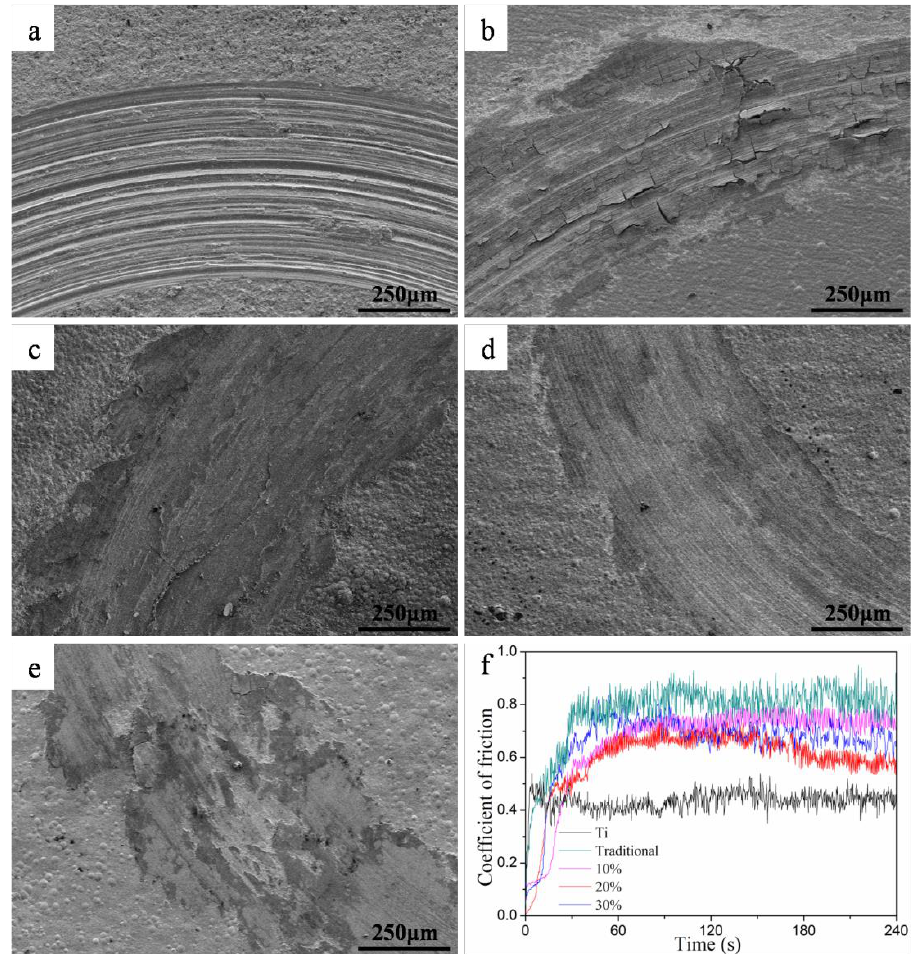
Figure 8. Morphologies of wear marks: ( a ) titanium alloy substrate; ( b ) traditional pretreatment coating; ( c ) 10% laser energy density cleaning coating; ( d ) 20% laser energy density cleaning coating; ( e ) 30% laser energy density cleaning coating; ( f ) the coefficient friction of coatings.